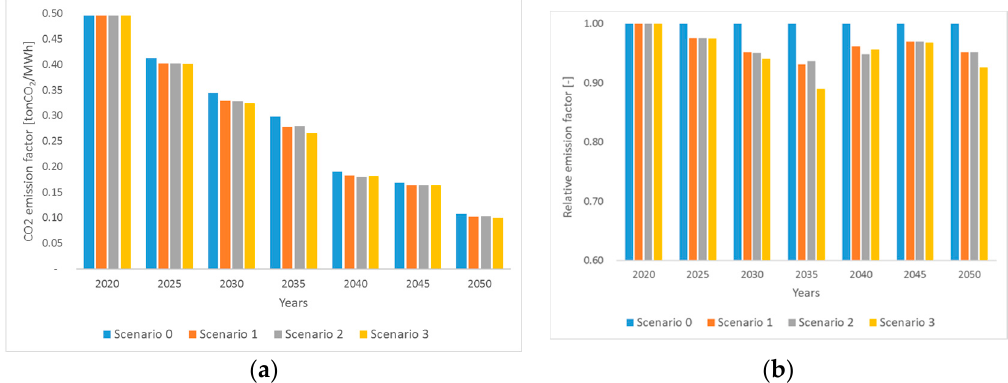
Figure 5. Evolution of the absolute emission factor ( a ) and the relative emission factor for Scenarios 1, 2 and 3 with respect to Scenario 0 ( b ). 2 and 3 with respect to Scenario 0 ( b